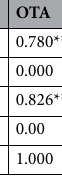
AFB 1 AFtotal OTA